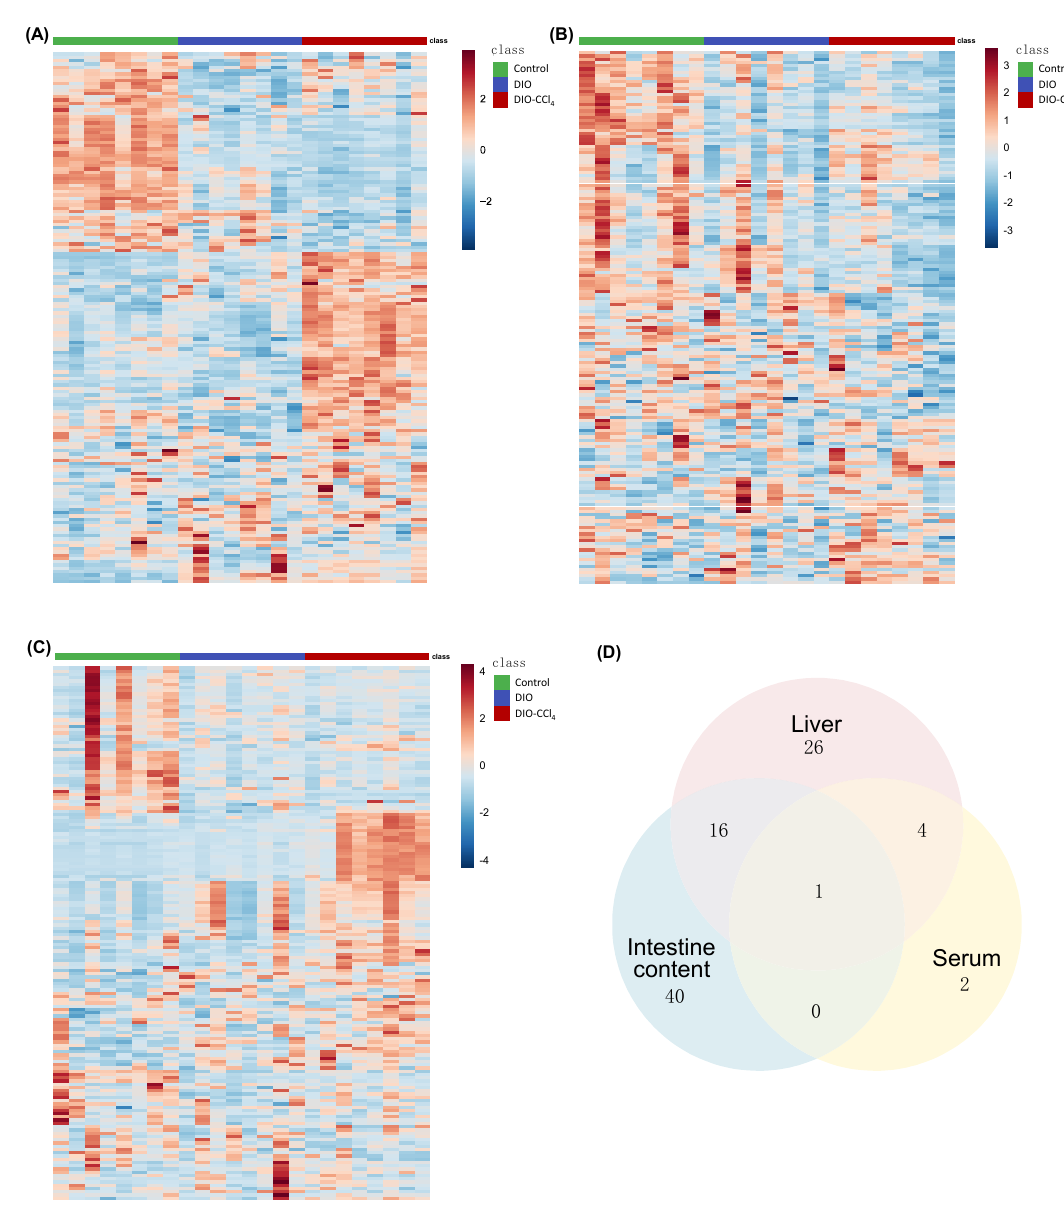
Figure 3. The metabolomic analysis of liver, serum and intestine content. Heatmaps of metabolic characteristics of liver ( A ), serum ( B ) and intestine content ( C ). ( D ) Venn plot of differential metabolites (The number means the shared differential